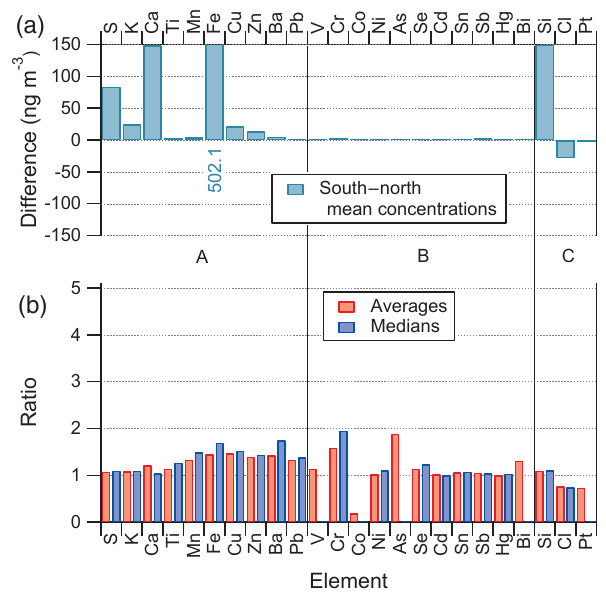
Figure 9. (a) “Background”-subtracted mean concentrations of the south sector for the non-fireworks period. Number indicates value outside the axis range for Fe. (b) Enhancement ratios for all anal- ysed elements for south–north sector classification for the non- fireworks period, sorted by